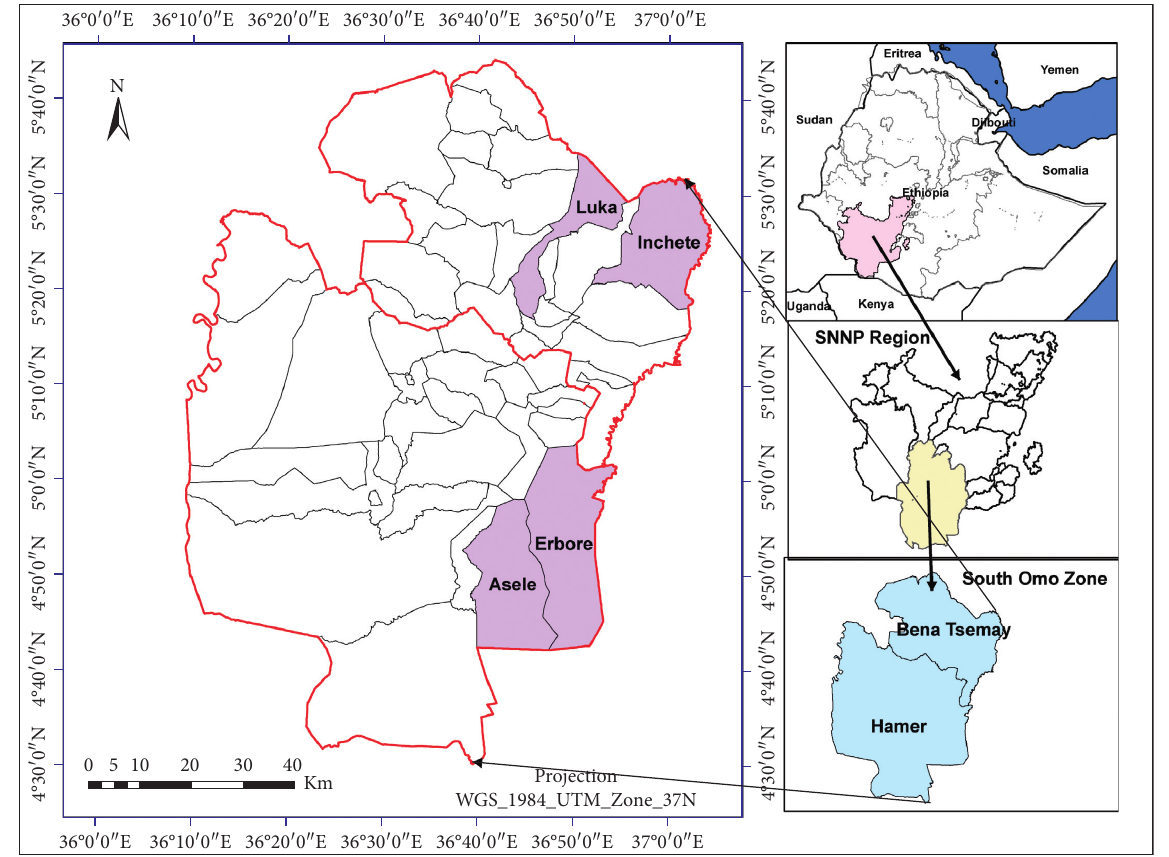
Figure 1: Map of the study area (source: authors